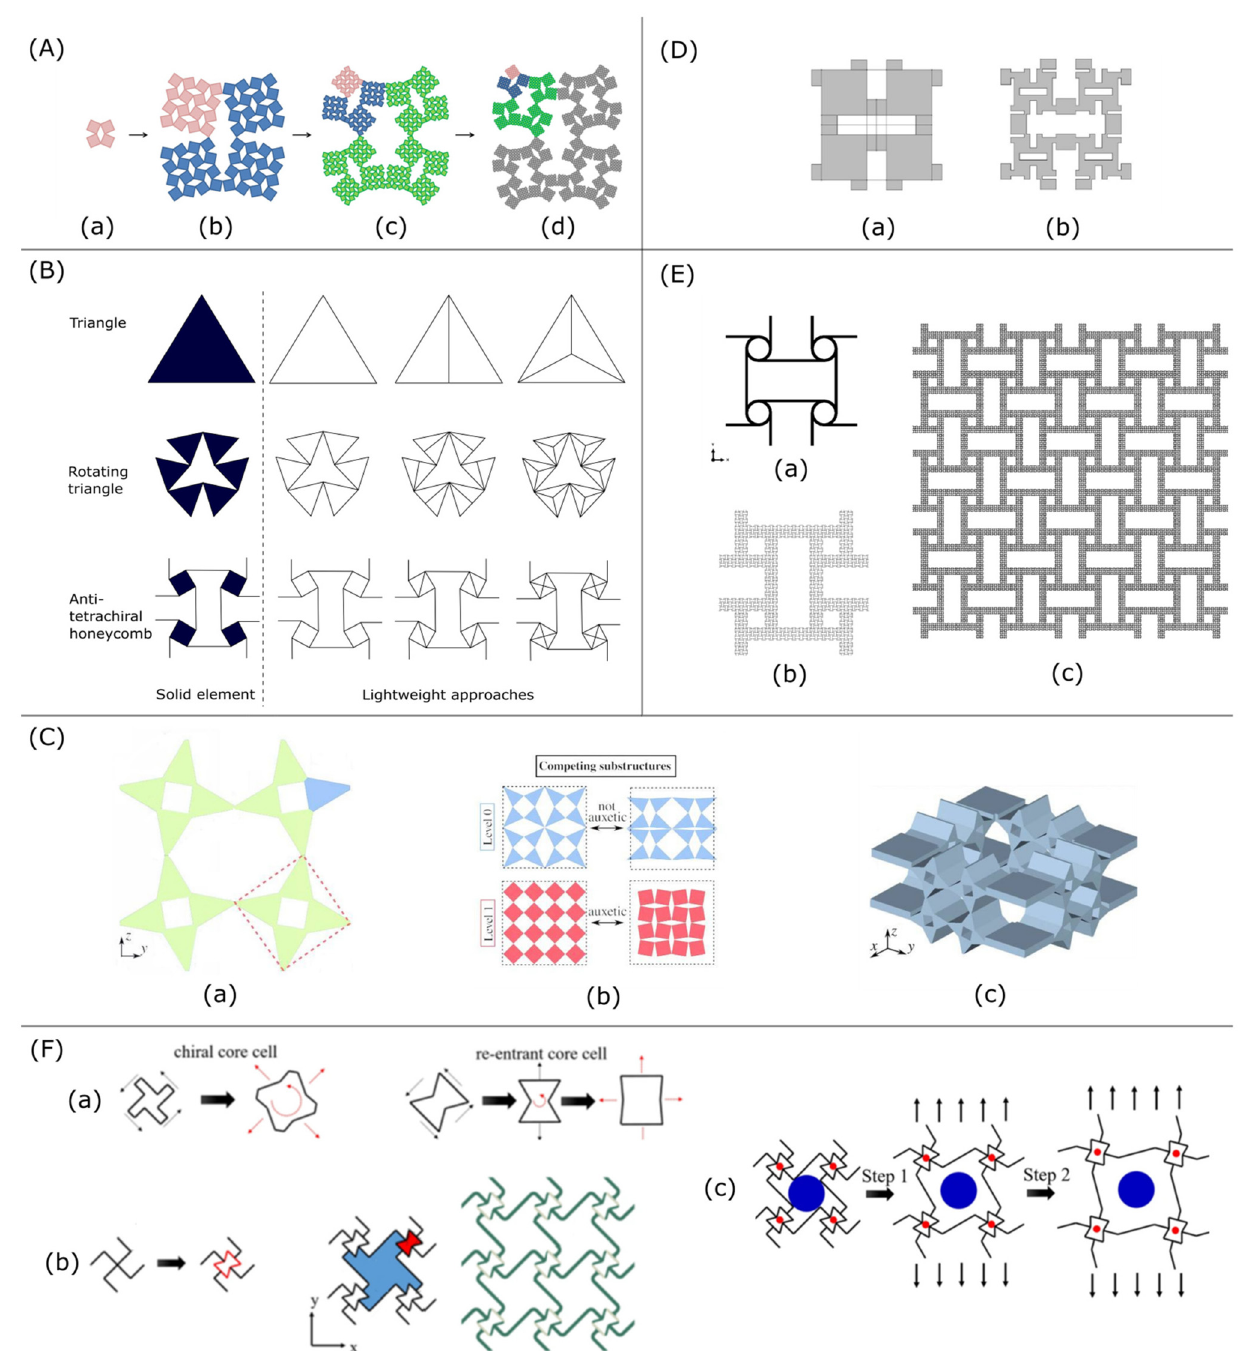
Figure 5. Utilization of rotating unit mechanism in material structure. ( A ): Diagram depicting hierarchical system based on the rotating rigid units mechanism: ( a ) one level system, ( b ) two level system, ( c ) three level system and ( d ) three level system part [67]. ( B ): Schematic design of possible approaches for substitution of rotating blocks with lattice cells for lightweight design of four auxetic rotating solid blocks structures. ( C ): The design of 2D and 3D hierarchical structure: ( a ) a cross- section of the unit-cell: in blue–level 0 element, in red–level 1 element, ( b ) conceptual deformation of substructures corresponding and ( c ) the unit-cell of the 3D model considered [68]. ( D ): ( a ) Geometry parameters of the base unit cell and ( b ) hierarchical, auxetic rectangular perforations 2 of the hierarchical structure [69]. ( E ): Model of second order hierarchical anti-tetrachiral metastructure: ( a )